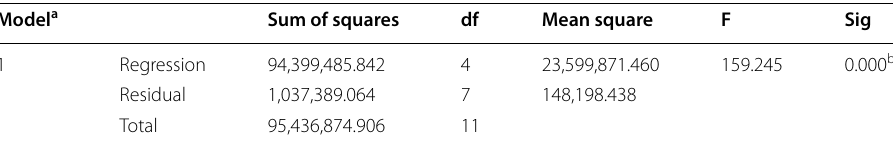
a Dependent variable: GDP mill. Euros